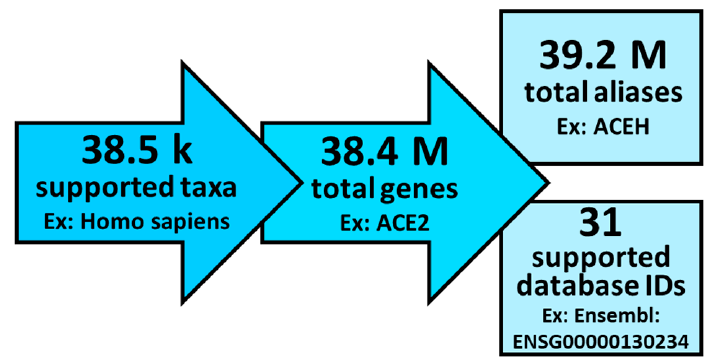
Figure 1. Overview of the gene information currently available to the GeneToList application.